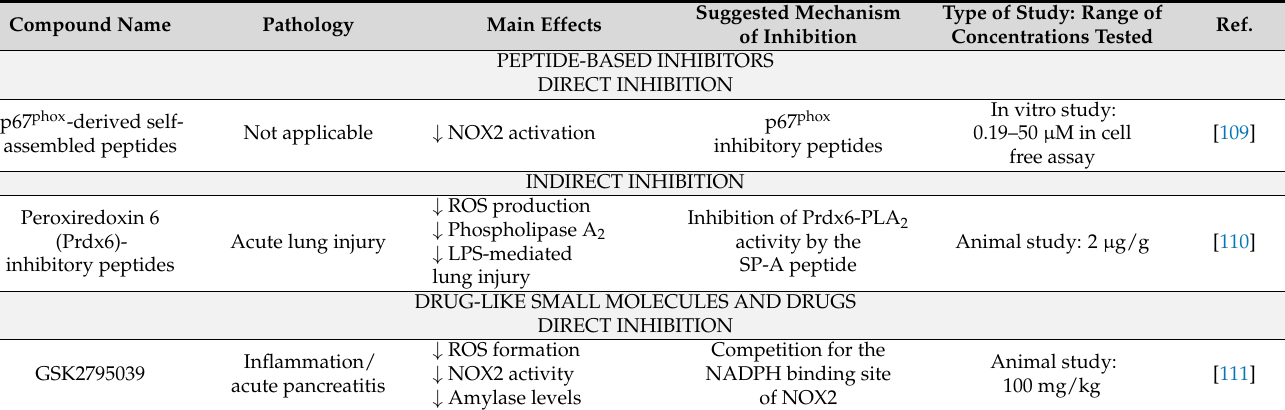
Table 1. Characteristics, molecular mechanism, and main effects of NOX2